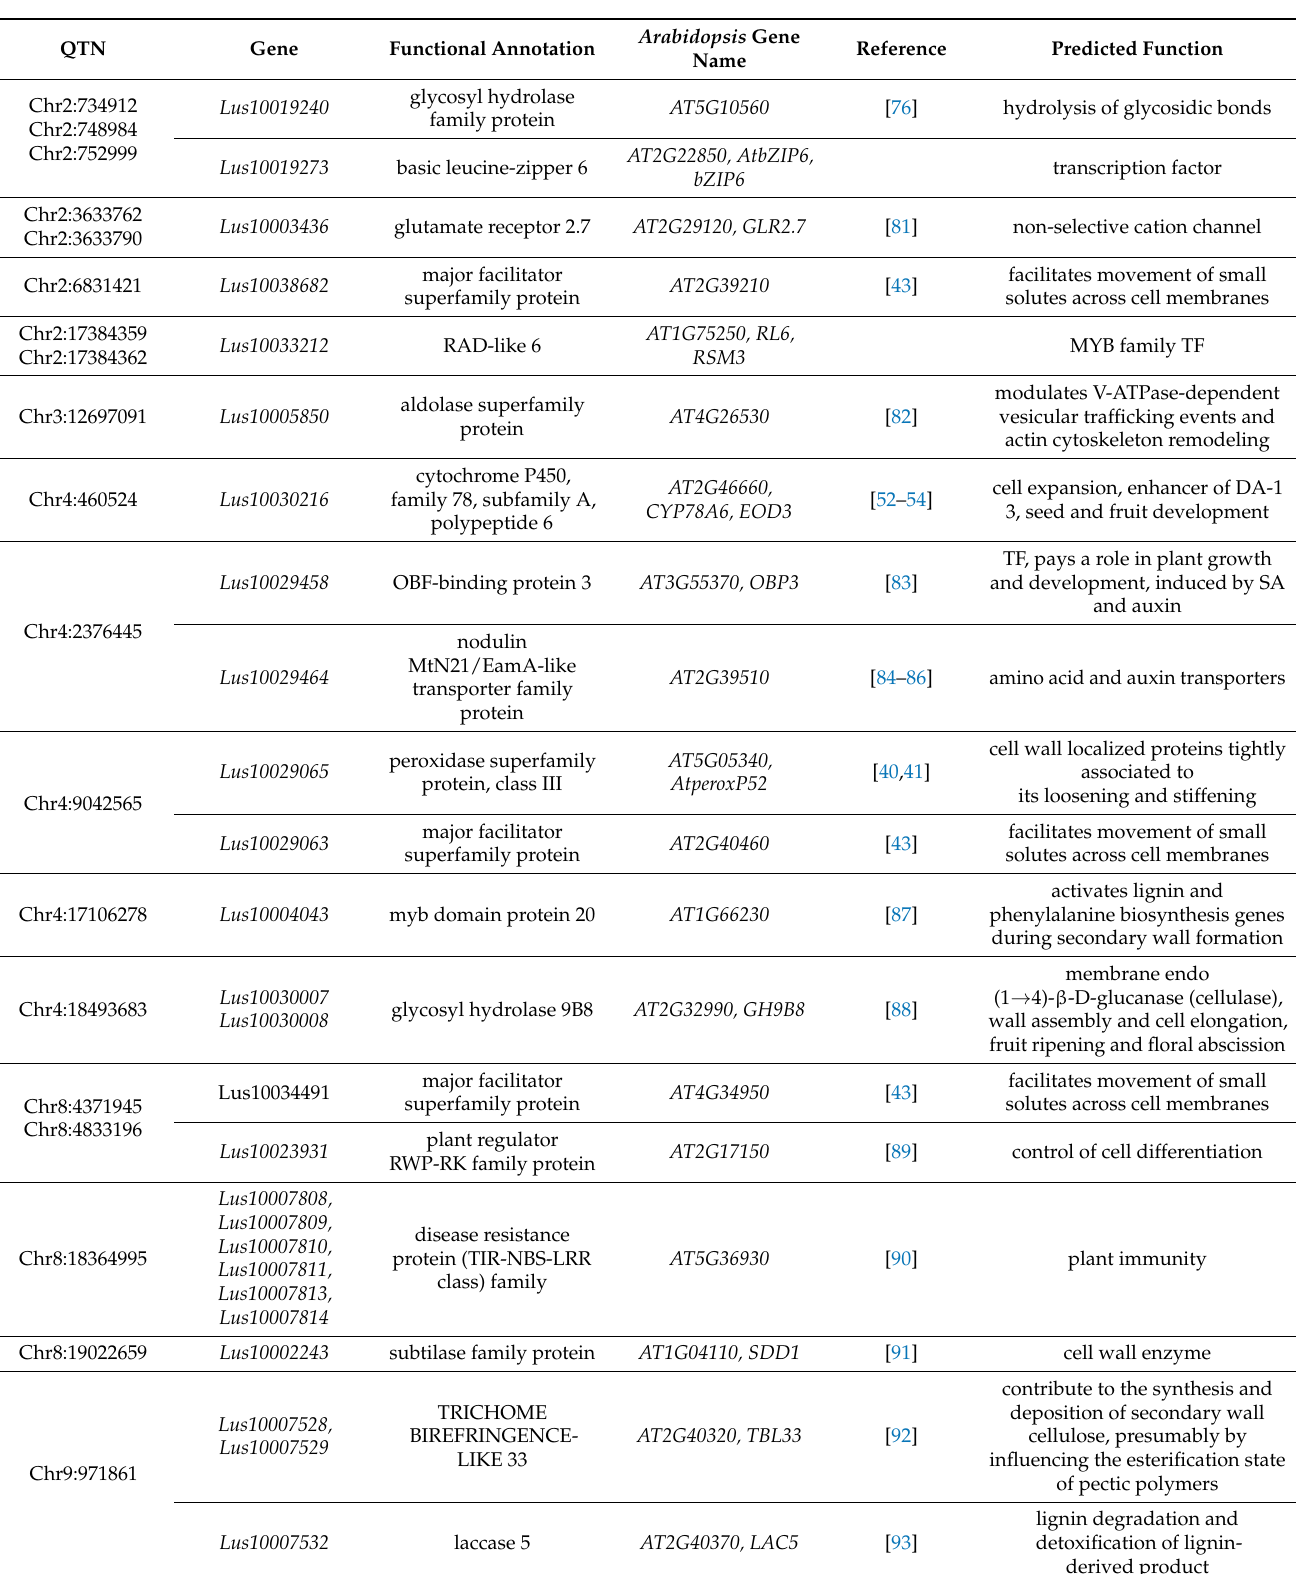
Table 2. Candidate genes predicted from the intersection of GEMMA hits with data on gene expres- sion in